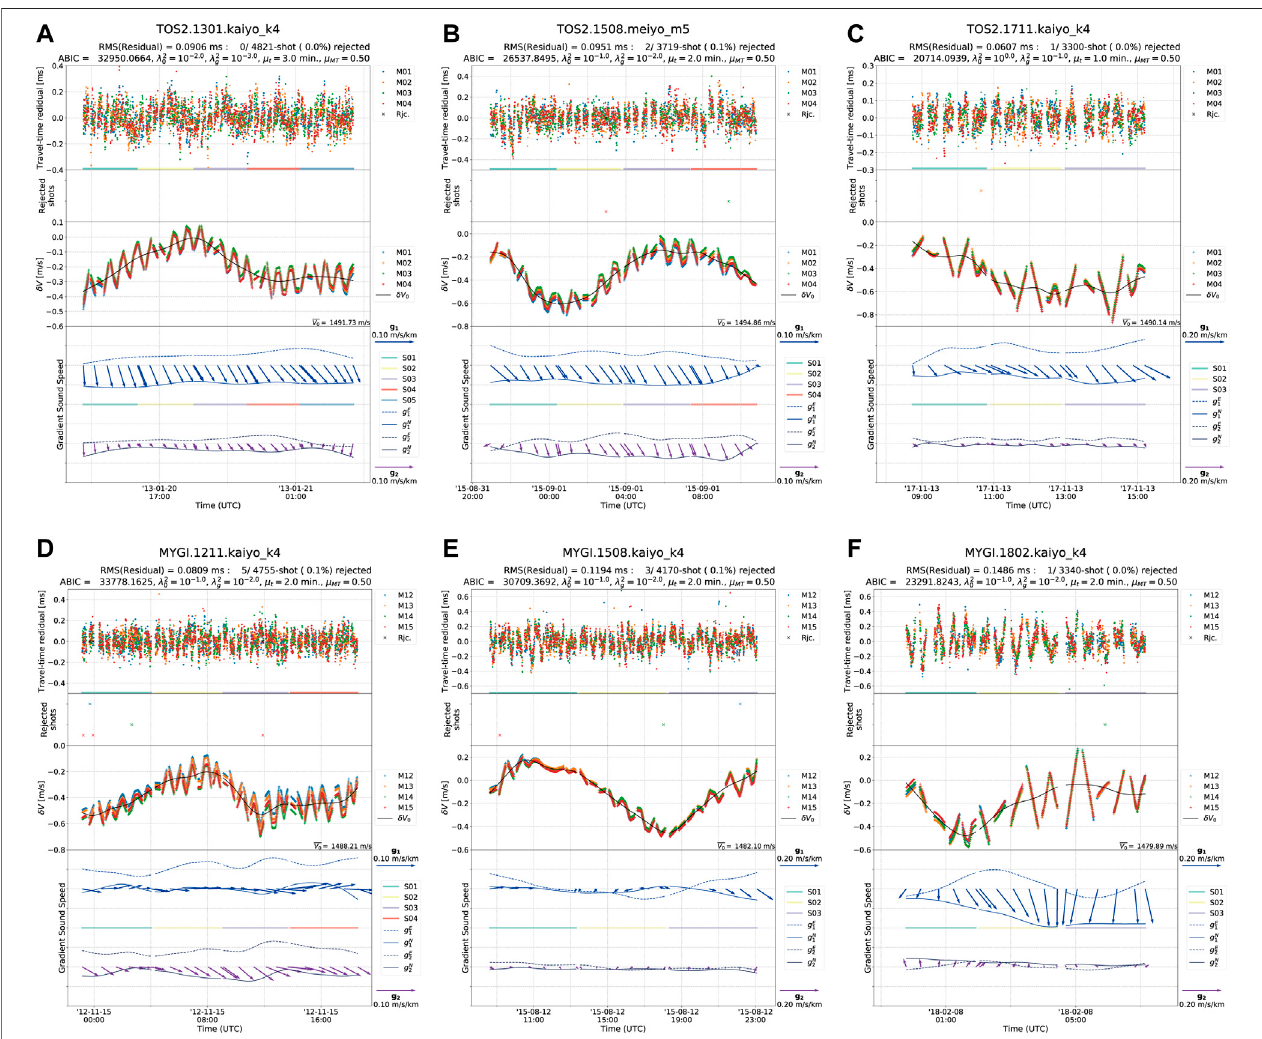
FIGURE 7 | Estimated results of the most preferred model for epochs (A) TOS2.1301.kaiyo_k4, (B) TOS2.1508.meiyo_m5, and (C) TOS2.1711.kaiyo_k4, (D) MYGI.1211.kaiyo_k4, (E) MYGI.1508.kaiyo_k4,and (F) MYGI.1802.kaiyo_k4.Thetoppanelsshowthemodelresidualsoftheround-triptraveltime.Thesecondpanels show the rejected acoustic data in the preprocessing step for determining the array geometry. The third panels indicate the sound speed perturbations, i.e., c crosses), and δ V 0 ( t ) ≡ V 0 α 0 ( t ) (black line). The colors of the symbols in these panels identify the target transponders. The blue and purple arrows on the bottom panels indicate the spatial gradient of the sound speed perturbations in north-up expression, i.e., g 1 ( t ) ≡ V 0 α 1 ( t ) , and g 2 ( t ) ≡ V 0 α 2 ( t ) , respectively. Dotted lines and